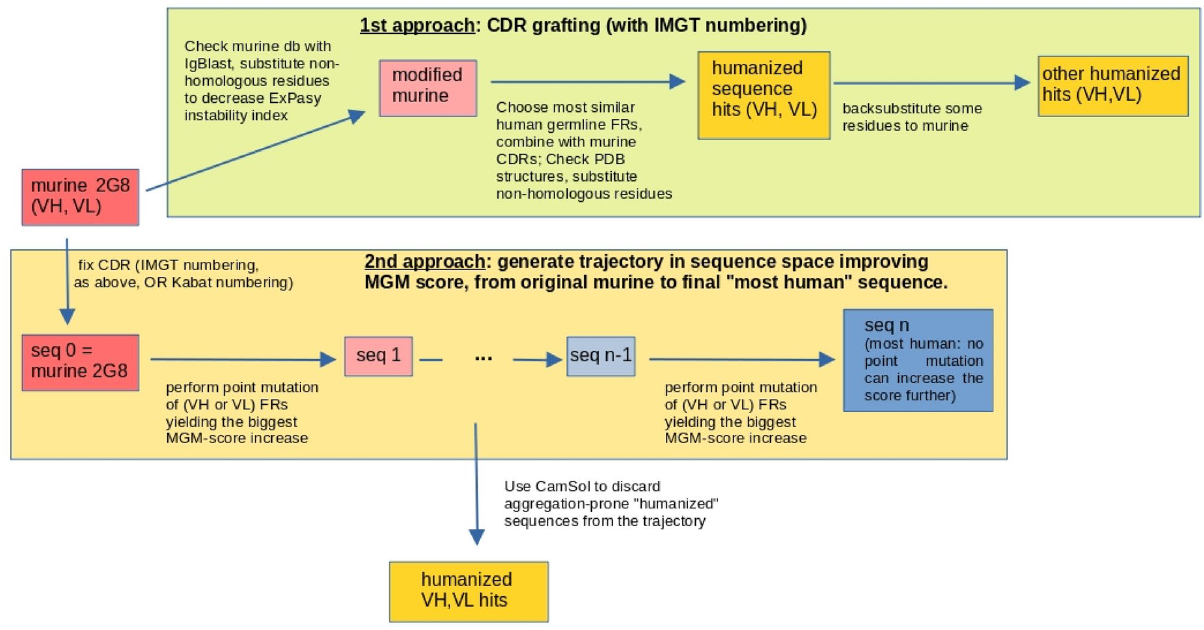
Figure 11. Flowchart of the humanization process: humanized sequences (in gold) are obtained according to either CDR grafting (above) or iterated MGM-score-based mutations (below); the latter approach yields a trajectory of increasingly human sequences from the original, murine one (red) to the final sequence, that cannot be further improved under point mutations (blue). CamSol Intrinsic server is used to select, among the sequence on this trajectory, the humanized hits as the ones that are sufficiently human and sufficiently